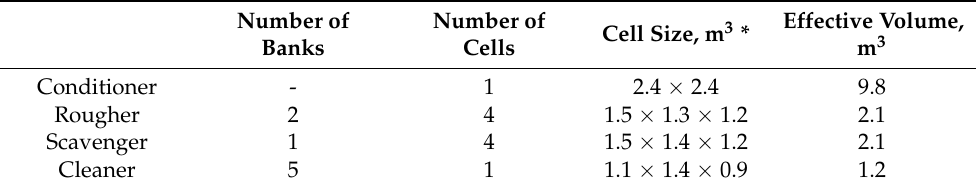
* Conditioner: diameter × higher; other cells: width × length ×